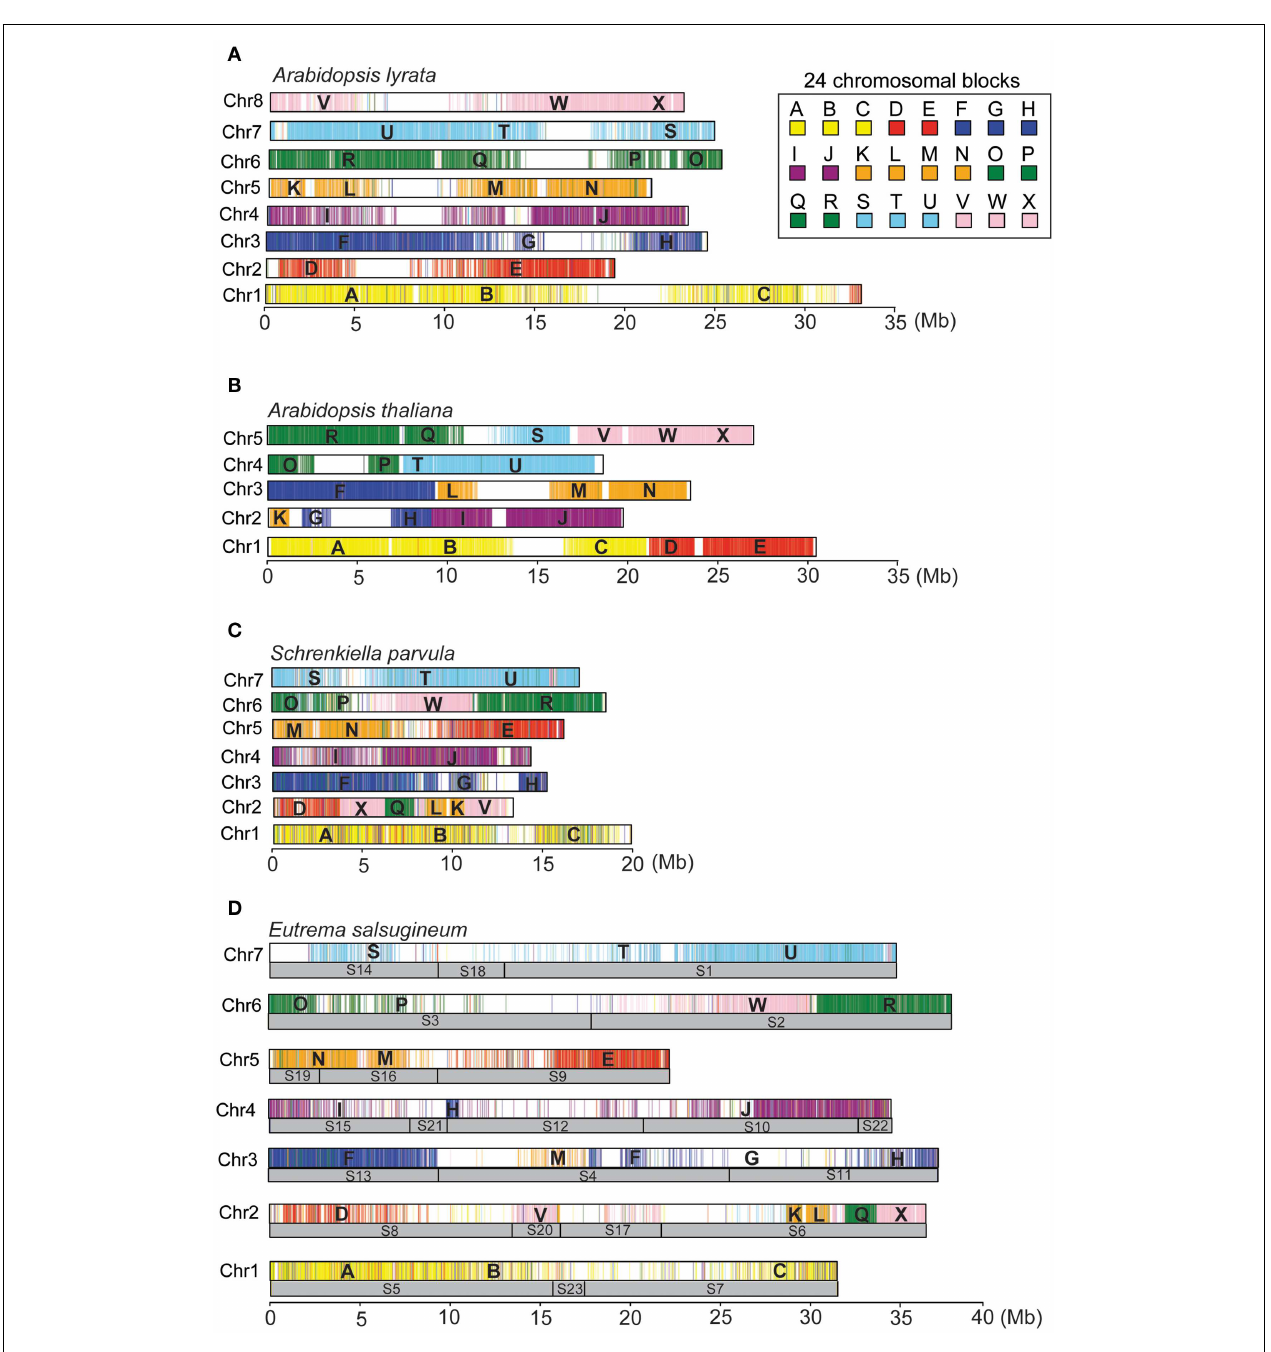
FIGURE 4 |The digital karyotypes of the A. lyrata (A), A. thaliana (B), S. parvula (C), and E. salsugineum (D) genomes.